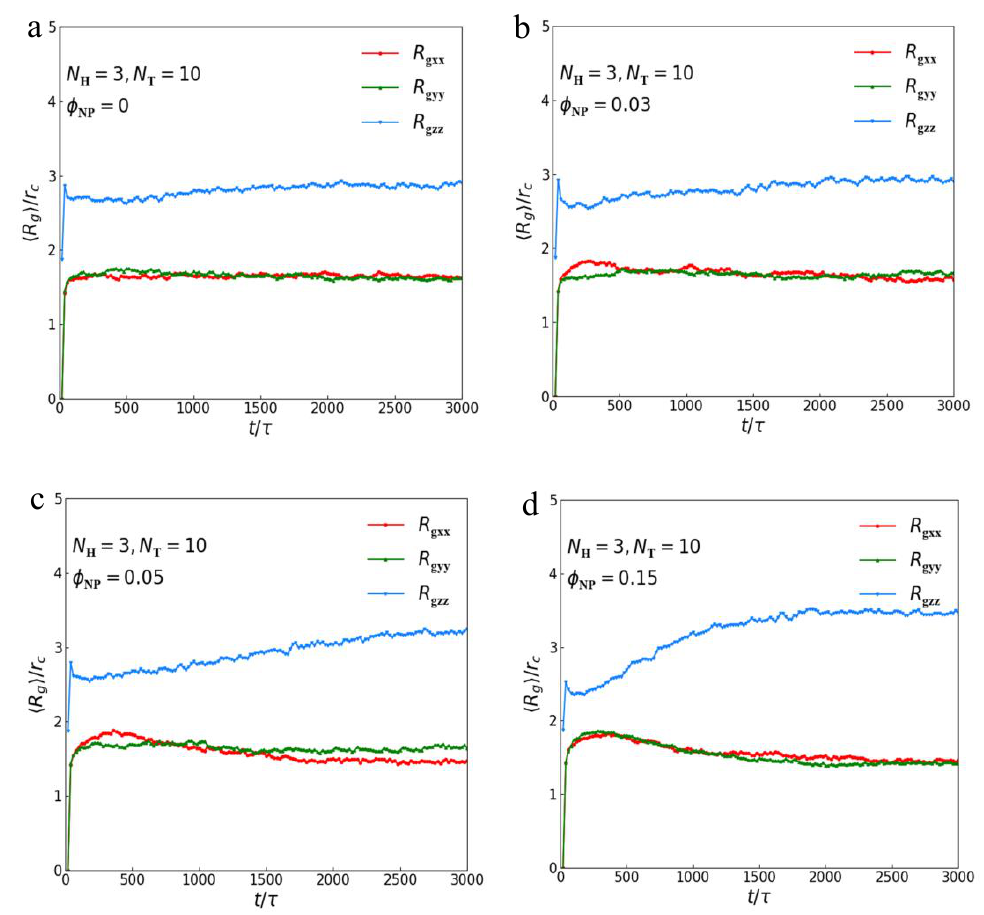
Figure 5. The average radius of gyration of lipid–nanoparticle mixtures with lamellar structure. There are three components as functions of time steps with ( a ) φ NP = 0, ( b ) φ NP = 0.03, ( c ) φ NP = 0.05 and ( d ) φ NP =